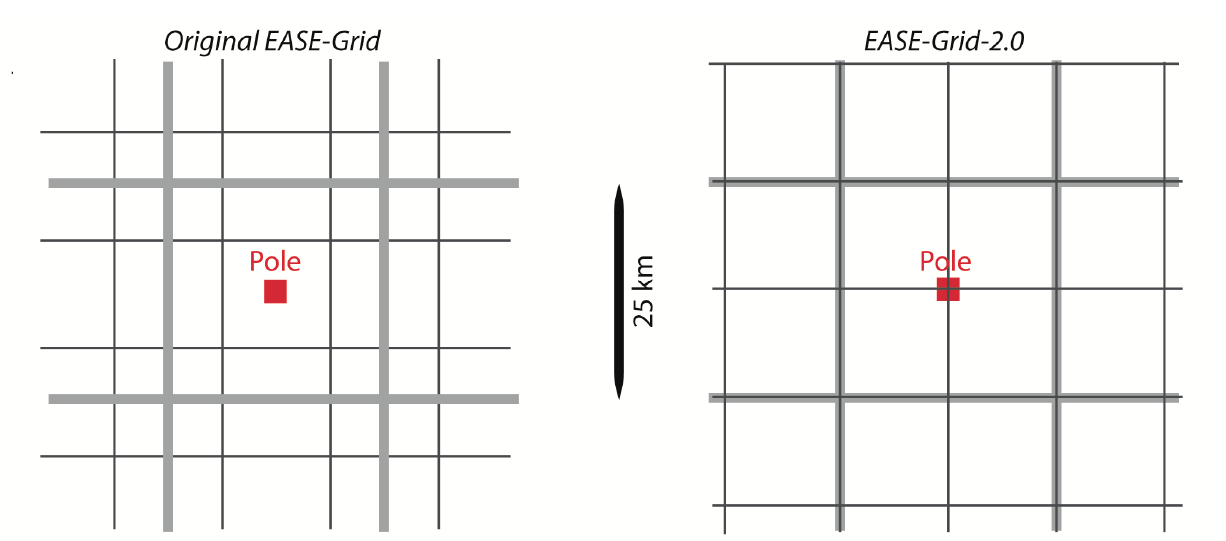
(1) The right hand side of Figure 5 is incorrect. Figure 5. Relative gridding schemes for representative azimuthal 25 km and 12.5 km original EASE-Grid (( Left ), bore-centered) vs . EASE-Grid 2.0 (( Right ), nested) cells near the